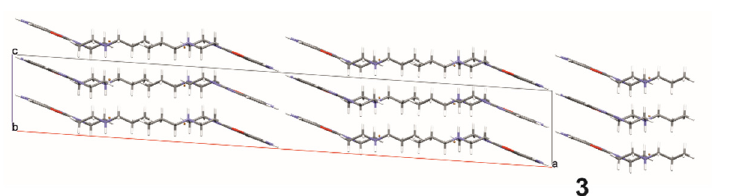
Figure 11. The crystal packing of 3 , viewed along the b-axis.